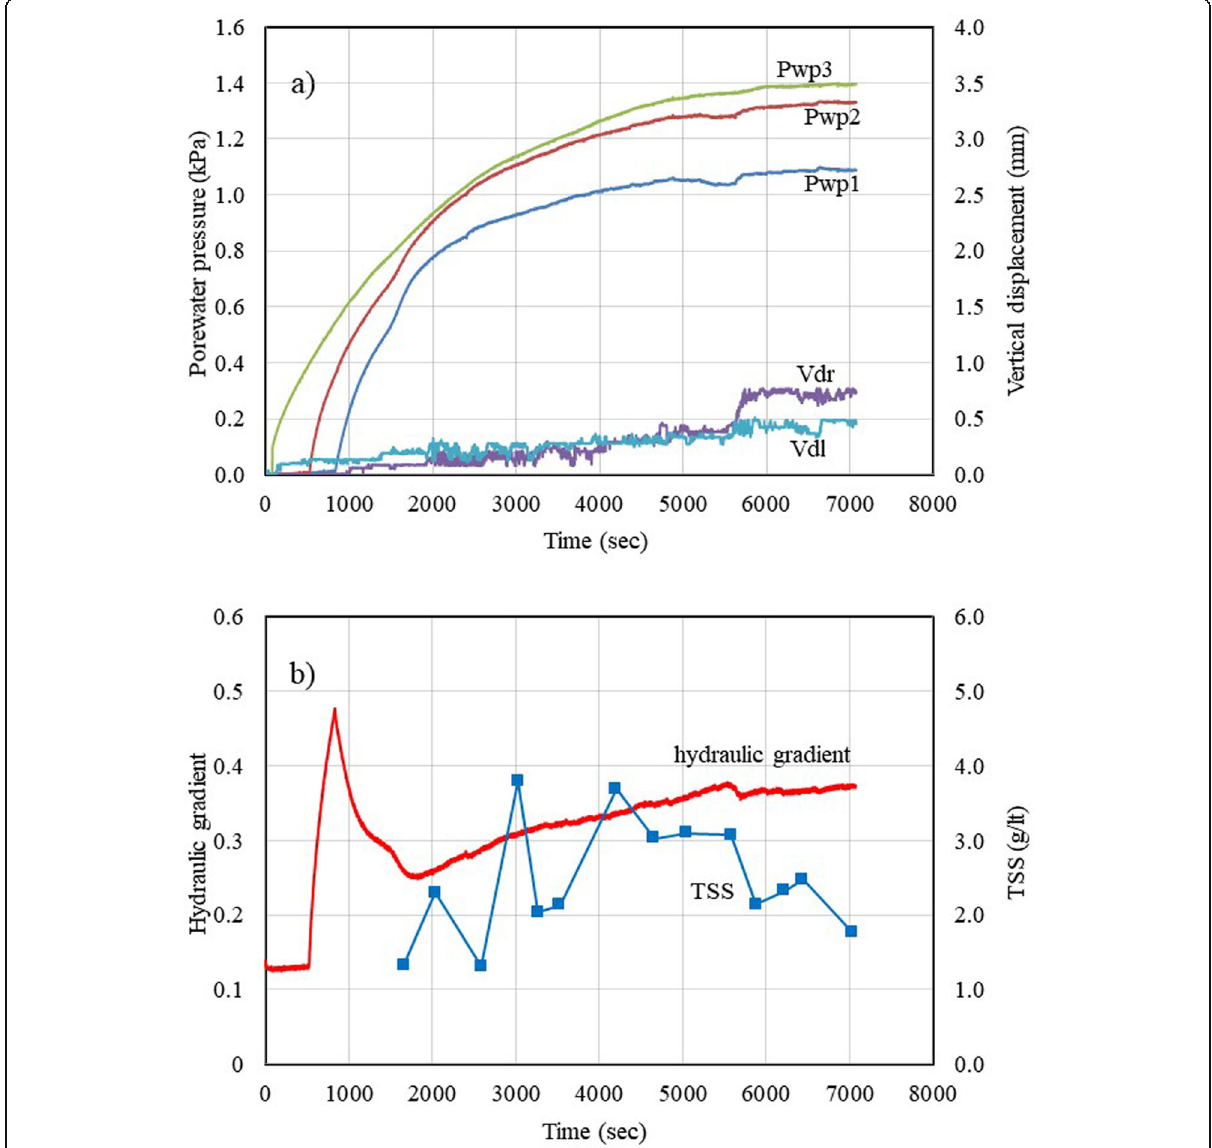
Fig. 7 Experiment results of experiment No. EXP 1NF of GI (with Kaolinite) sample. a Pore water pressure and vertical displacement b Hydraulic gradient and